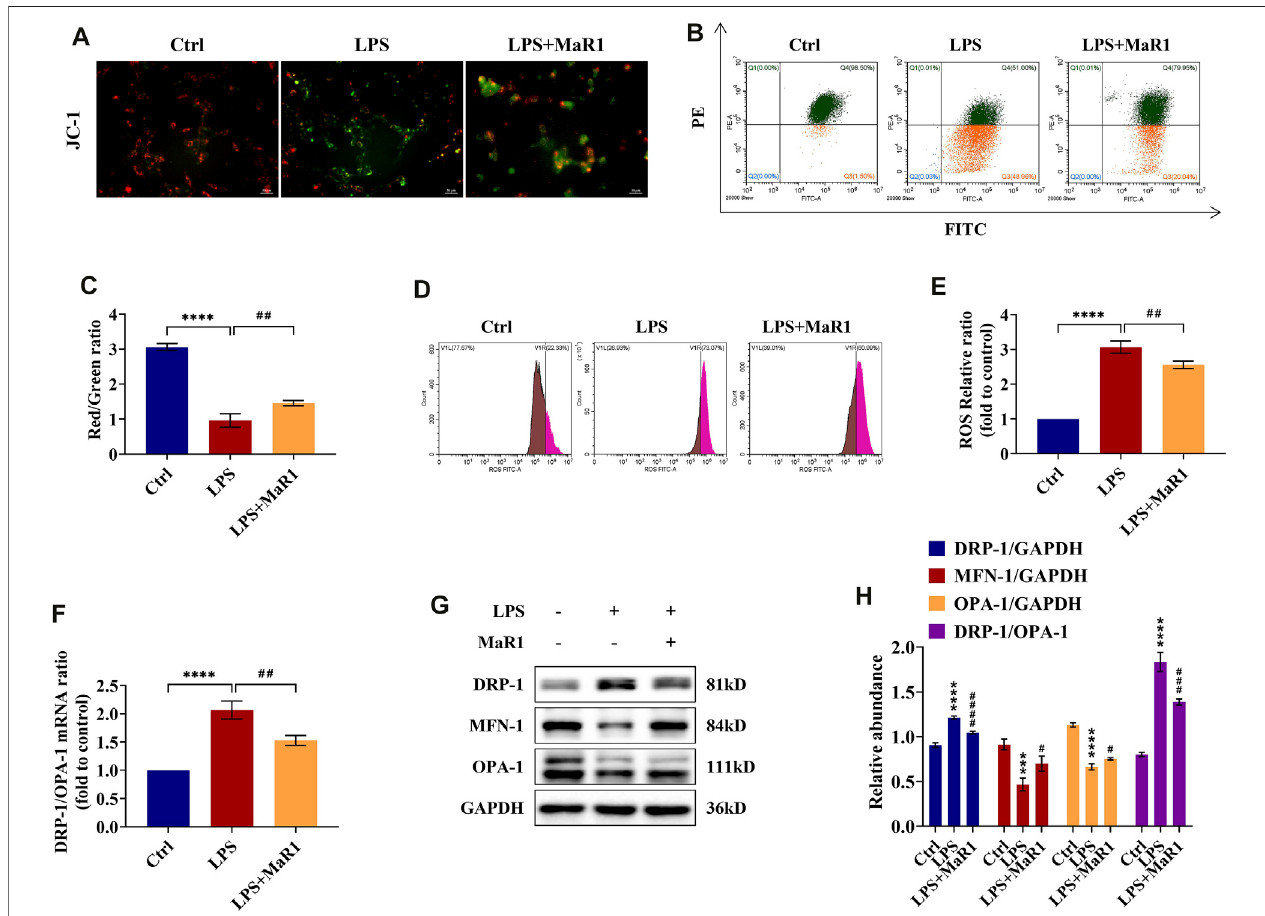
FIGURE6| MaR1preservedthemitochondrialqualityandreducedthereactiveoxygenspecies(ROS)levelsoflipopolysaccharide(LPS)-stimulatedTCMK-1cells. (A) Representative pictures of JC-I staining of TCMK-1 cells (scale bar (cid:2) 50 μ m). (B) Flow cytometry analysis of MMP using JC-1 staining. (C) Red/green fl uorescence ratio of JC-1 staining of TCMK-1 cells in each group. (D) The ROS levels of TCMK-1 cells were determined by fl ow cytometry. (E) ROS relative ratio of TCMK-1 cells in eachgroup. (F) ThegeneexpressionratioofDRP-1/OPA-1inTCMK-1cellswasquantitatedusingqRT-PCR. (G) TheexpressionsofDRP-1,MFN-1,andOPA-1in TCMK-1cellswereanalyzedusingWesternblot. (H) TheproteinlevelsofDRP-1,MFN-1,andOPA-1werequanti fi edbydensitometryandnormalizedwithGAPDH(time point:24 h).Dataarepresentedasmean ± SD, n (cid:2) 5.* p < 0.05,** p < 0.01,*** p < 0.001,**** p < 0.0001 vs .controlgroup;# p < 0.05,## p < 0.01,### p < 0.001,#### p < 0.0001 vs . LPS